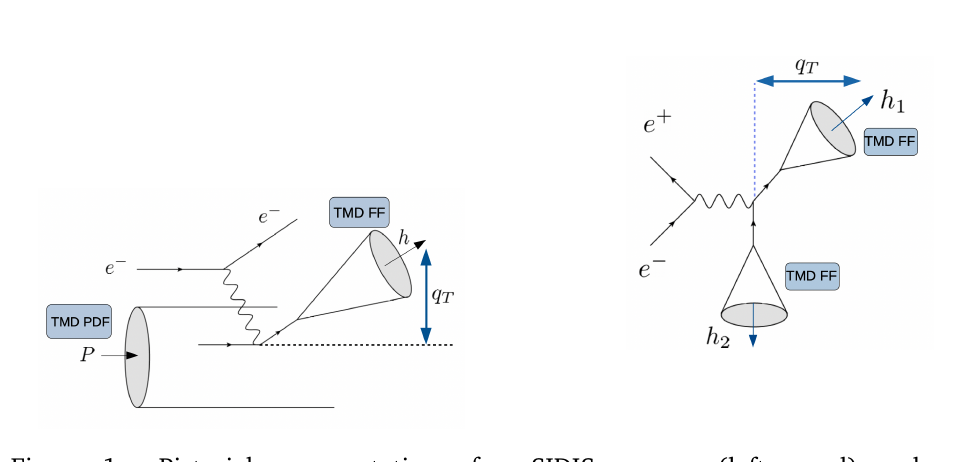
Figure 1: Pictorial representation of a SIDIS process (left panel) and an e + e − → h h X scattering (right 1 2